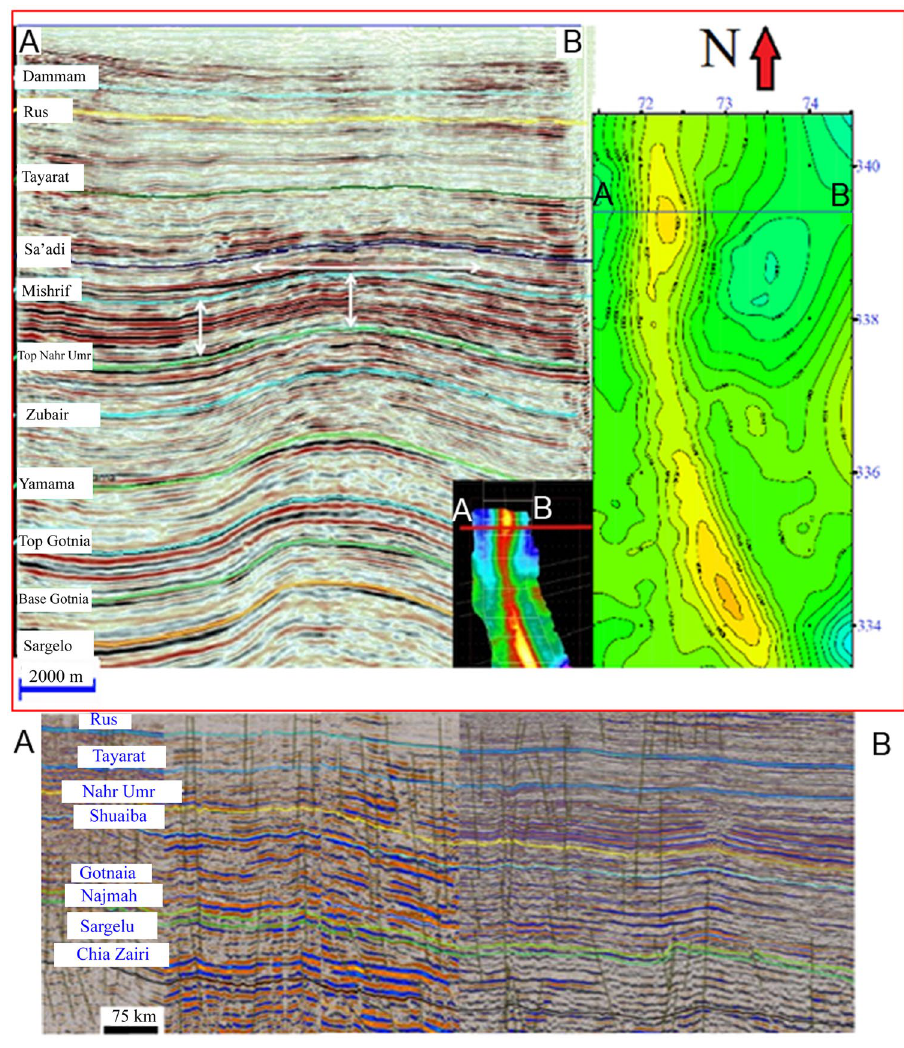
Fig. 8 Seismic section perpen- dicular to the anticline axis in the R